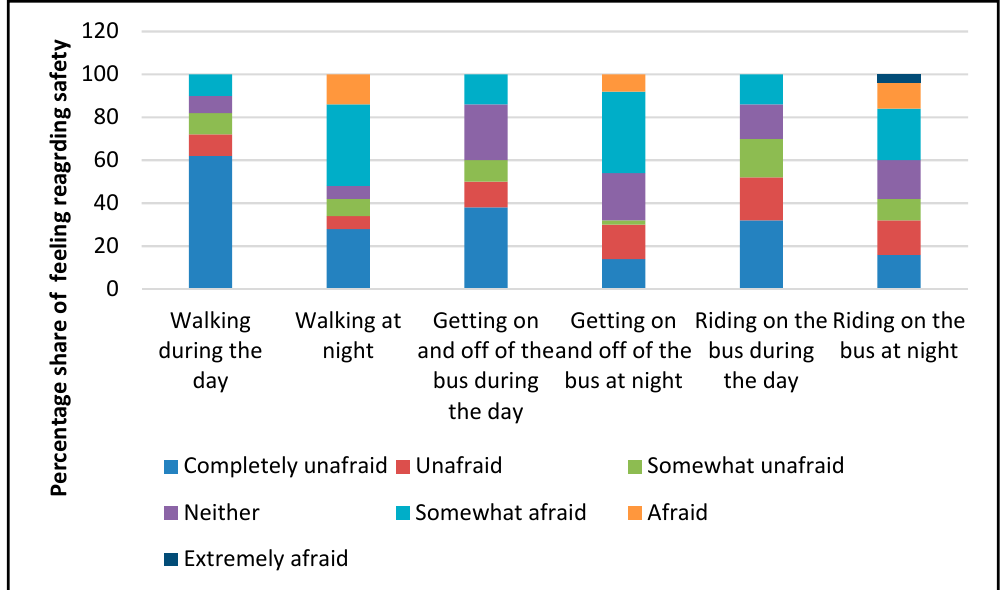
Figure 4. Perception of safer environment within activity space during different timespans along a 24-h day.